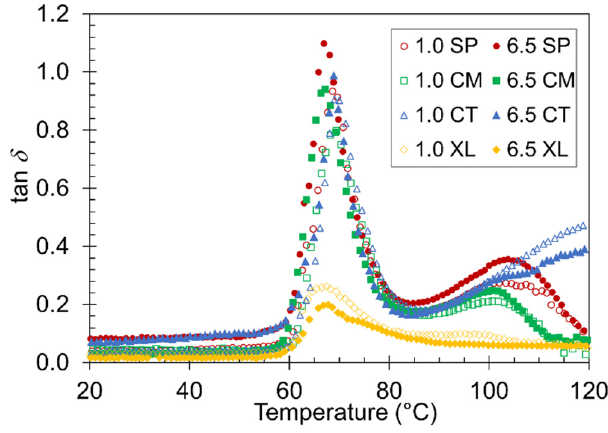
Figure 7. Representative plots of tan δ versus temperature for the four contrastive foams with 1.0 wt% and 6.5 wt% CFA.